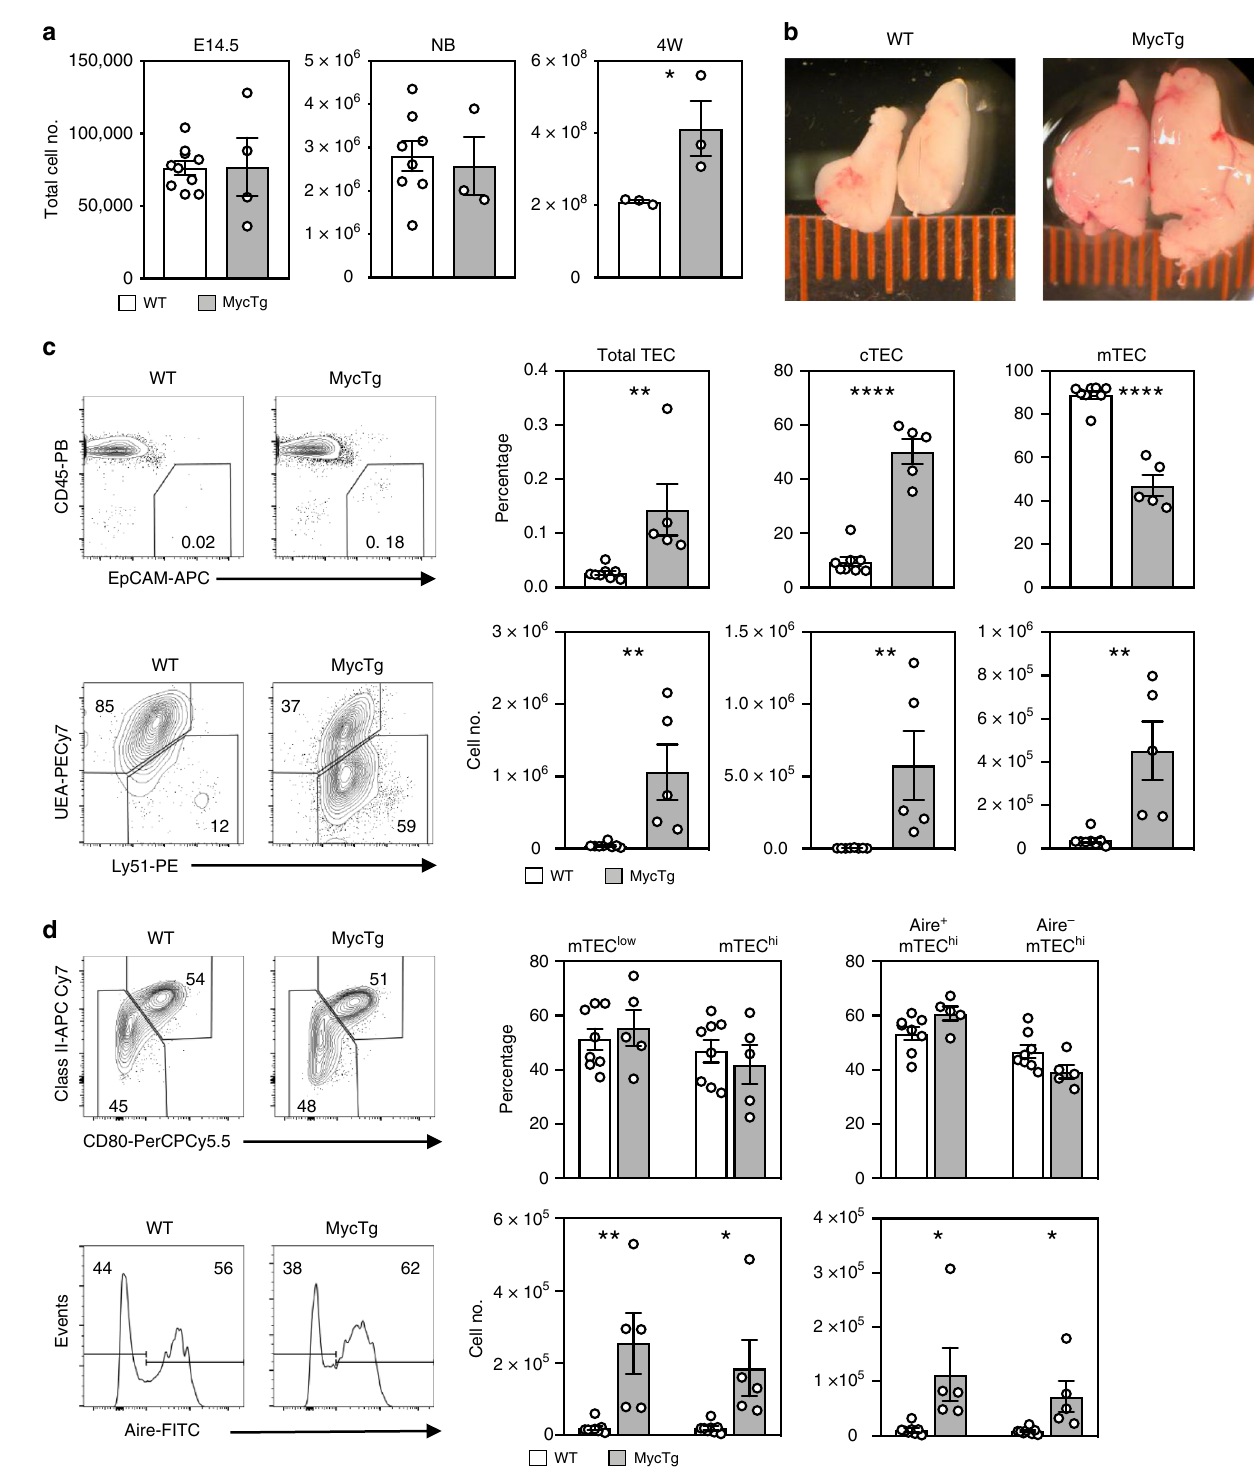
Fig. 4 Transgenic expression of Myc in TEC drives thymic growth. a Total thymus counts of WT (white bars) or FoxN1MycTg (gray bars) mice at embryonic day 14.5 (E14.5), newborn (NB) or 4 weeks of age. b Photographs of 10-week-old thymi from WT (left) or FoxN1MycTg (right) mice. c Representative fl ow plots of the frequency of CD45 − EpCAM + total TEC (above), or Ly51 + UEA − cTEC and Ly51 − UEA + mTEC pre-gated on CD45 − EpCAM + total TEC (below), from 4-week-old WT or FoxN1MycTg mice. Bar graphs display the frequency (above) or cell number (below) of total TEC (left), cTEC (middle) or mTEC (right) of adult WT or FoxN1MycTg mice. d Representative fl ow plots of CD80 + ClassII + mTEC hi or CD80 − ClassII low mTEC low , pre-gated on Ly51 − UEA + mTEC, or histograms displaying the frequency of Aire + and Aire − cells pre-gated on CD80 + ClassII + mTEC hi from WT or FoxN1MycTg mice. Bar graphs display the frequency (above) or numbers (below) of the corresponding populations. All bar graphs show mean ± SEM for a minimum n = 3 mice per genotype. A two-tailed unpaired Student ’ s t test was performed to determine signi fi cance. * p < 0.05, ** p < 0.01, **** p < 0.0001. The source data underlying ( a ), ( c ), ( d ) are provided as a Source Data fi